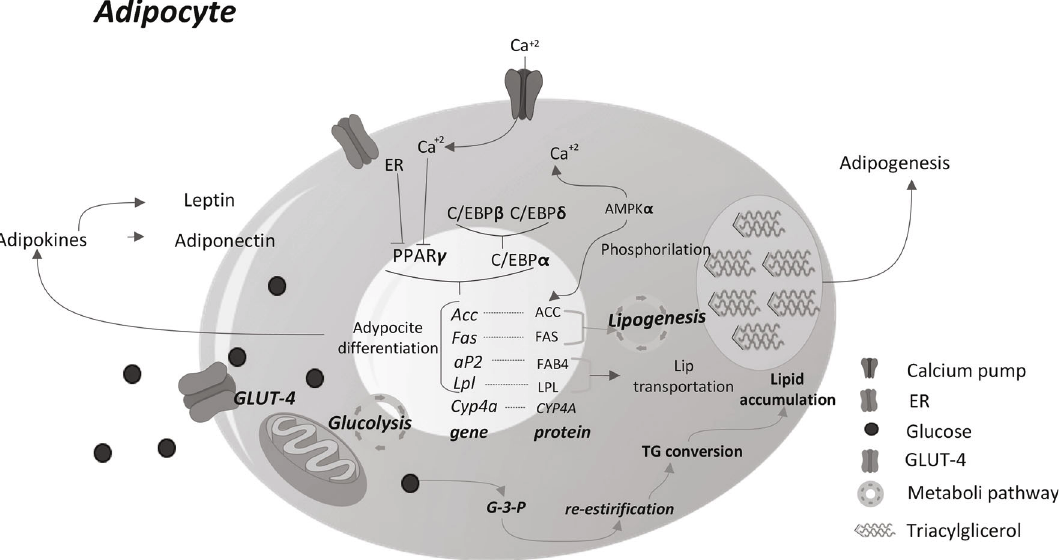
Figure 1: Activation of PPAR γ and its interaction with lipid metabolism on the adipocyte. El PPAR γ is conditioned to C/EBP α activation, once activated the receptor can recognize and bind to a PEP sequence of the genes of Acc, Fas, Ap2 y Lpl , which are involved with lipogenesis, adipocyte di ff erentiation, lipid accumulation, and adipogenesis; lets the secretion of adipokines, therefore, are used as biomarkers of PPAR γ activation. Also, the activation can be blocked by the accumulation of Ca +2 ions and ER activation. Abbreviations: ACC, acetyl Co-A carboxylase; AMPK α , AMP-activated protein kinase; C/EBP α -, CCAAT enhancer binding protein alpha; C/EBP- β , CCAAT enhancer binding protein beta; C/EBP-d, CCAAT enhancer binding protein delta; ER, estrogen receptor; FABP4, fatty acid- binding protein 4; FAS, fatty acid synthase; GLUT-4, glucose transporter type 4; LPL, lipoprotein lipase; PPAR γ , peroxisome proliferator-activated receptor gamma; TG,